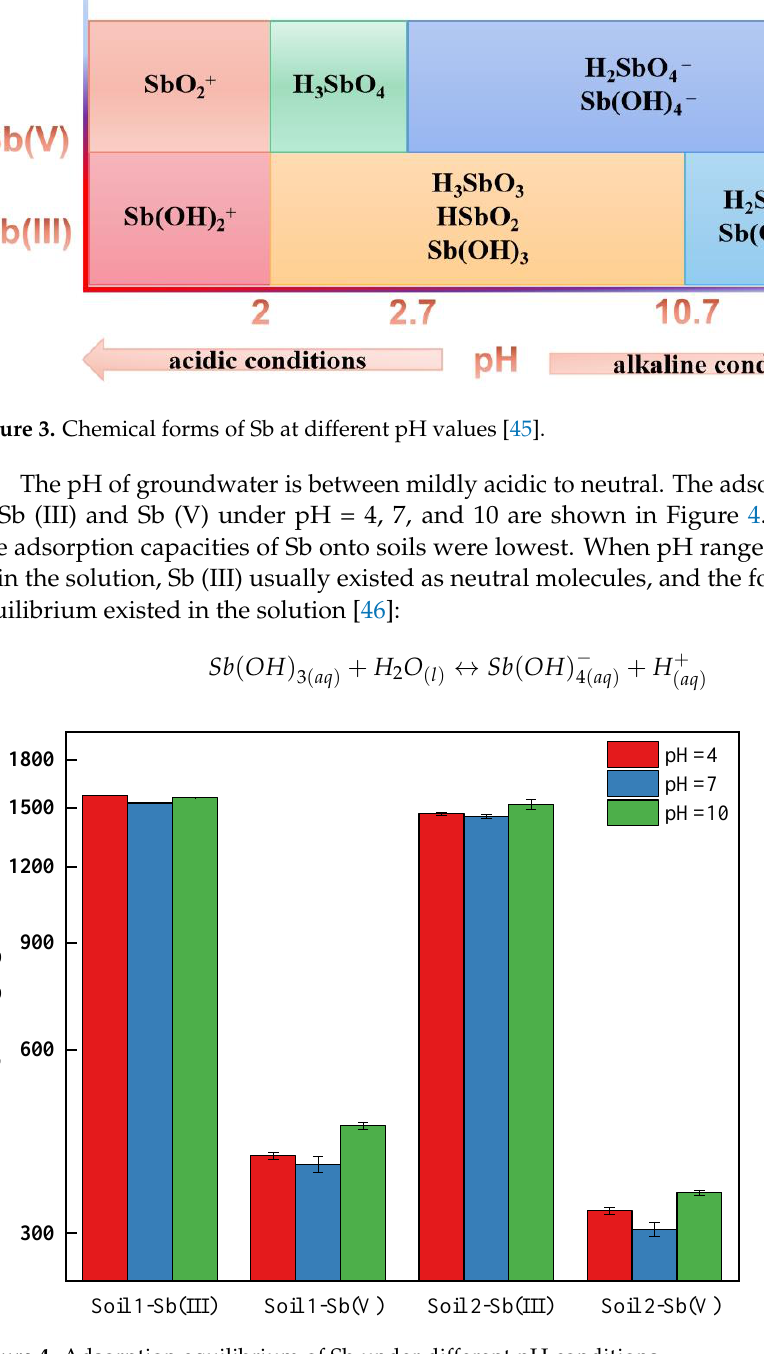
Figure 4. Adsorption equilibrium of Sb under different pH conditions.